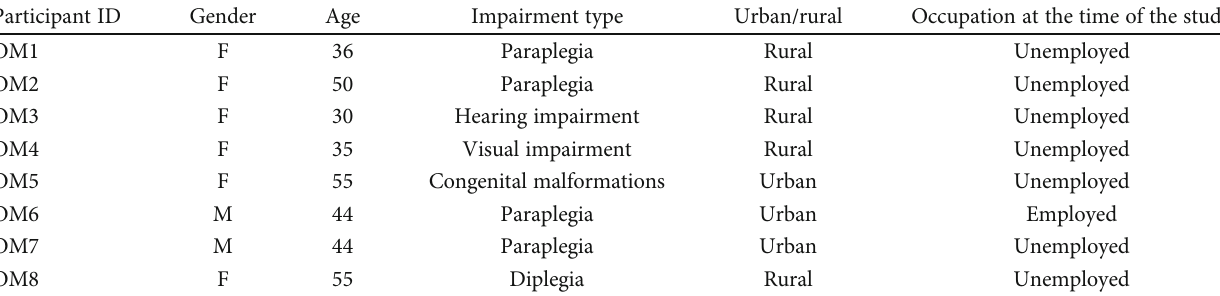
Table 1: Summarised description of participants with disabilities from the Omusati region that engaged in a focus group discussion ( n = 8 ).